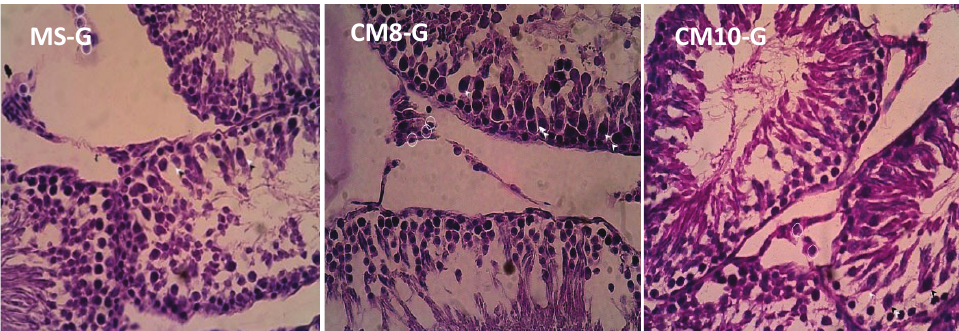
Figure 1 . Leydig and Sertoli cells on Hematoxylin Eosin stain method identified by light microscope with 400x